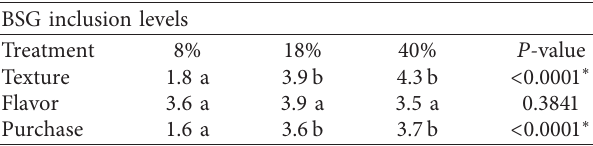
Figure 4: L ∗ , a ∗ , and b ∗ color values for brewer’s spent grain chip samples. Values shown are mean ± standard deviation; n � 3 replications, with 10 subsamples per treatment. Values accompanied by the same letter have means that are not significantly different ( p ≤ 0 . 05). Table 4: Calculated hue angle values for BSGC samples. Table 5: Mean responses from informal sensory analysis of brewer’s spent grain chip (BSGC) samples with three different BSG inclusion levels ( n �